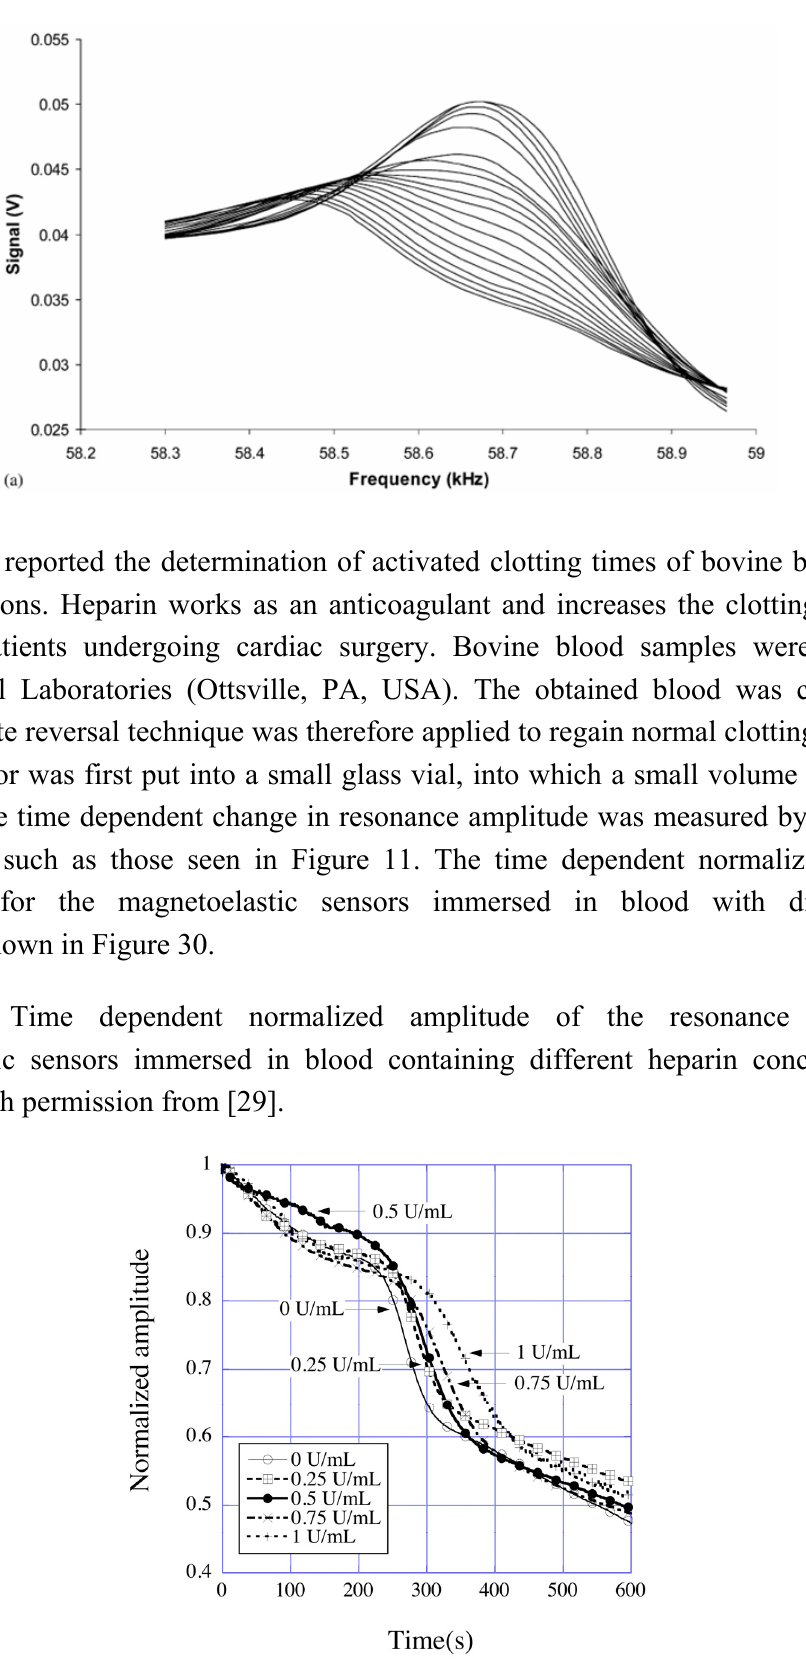
Figure 29. Frequency scan over time for a magnetoelastic sensor with a drop of blood on its surface; as the blood droplet clots both the resonance frequency and amplitude are reduced. Reprinted with permission from [28].